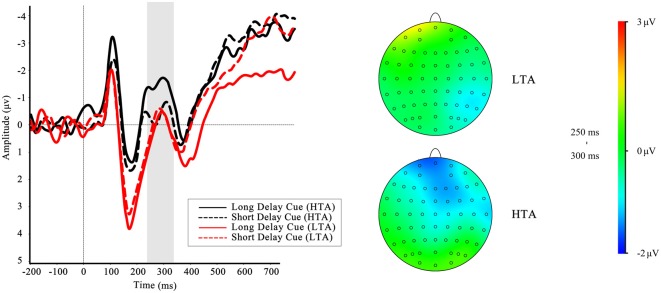
Cue-locked event-related potential (ERP) waveforms at Fz comparing long- and short-delayed cues in high trait anxiety (HTA) and low trait anxiety (LTA) groups, along with different waveforms and topographic maps for long- and short-delayed cues in HTA and LTA groups in time range of feedback-related negativity (FRN). Gray shaded area shows the 240–340 ms analysis window in which the FRN-like was quantified.